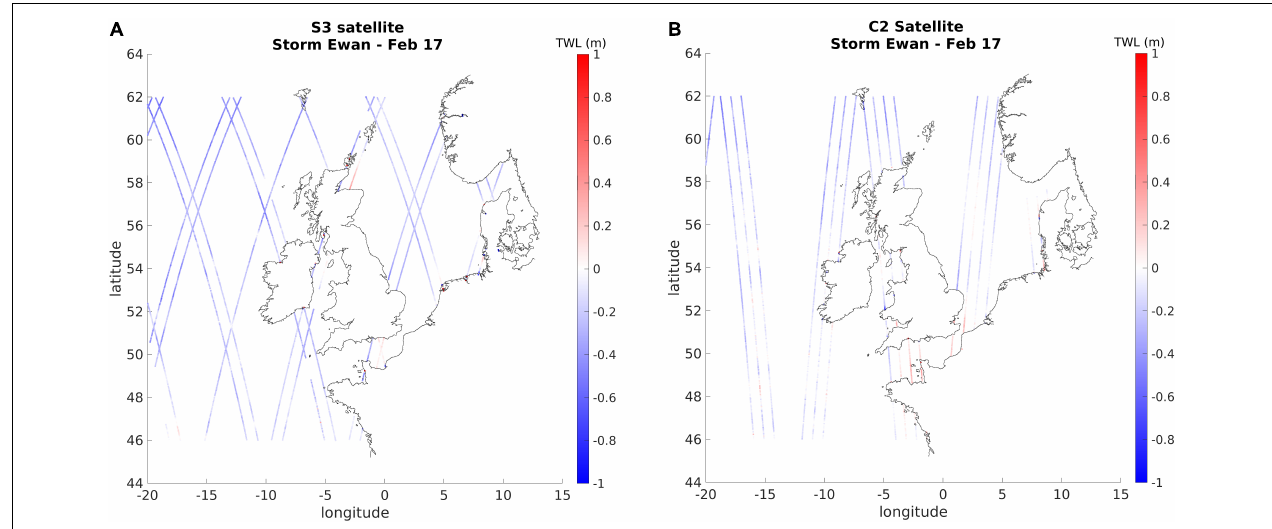
FIGURE 2 | (A) TWL difference between Amm15 and S3 for the 7-day period between 25 February 2017 and 03 March 2017 during Storm Ewan. (B) TWL difference between Amm15 and C2 for the 7-day period between 25 February 2017 and 03 March 2017 during Storm Ewan.